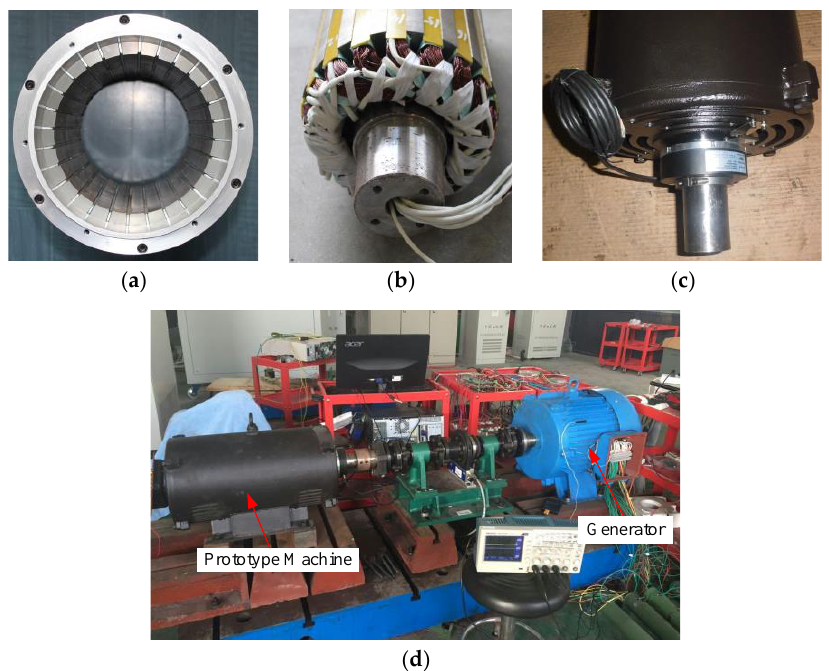
Figure 10. Prototype of proposed 18-slot/8-pole FMPM machine. ( a ) Outer rotor; ( b ) stator; ( c ) prototype assembly; and ( d ) experimental setup.